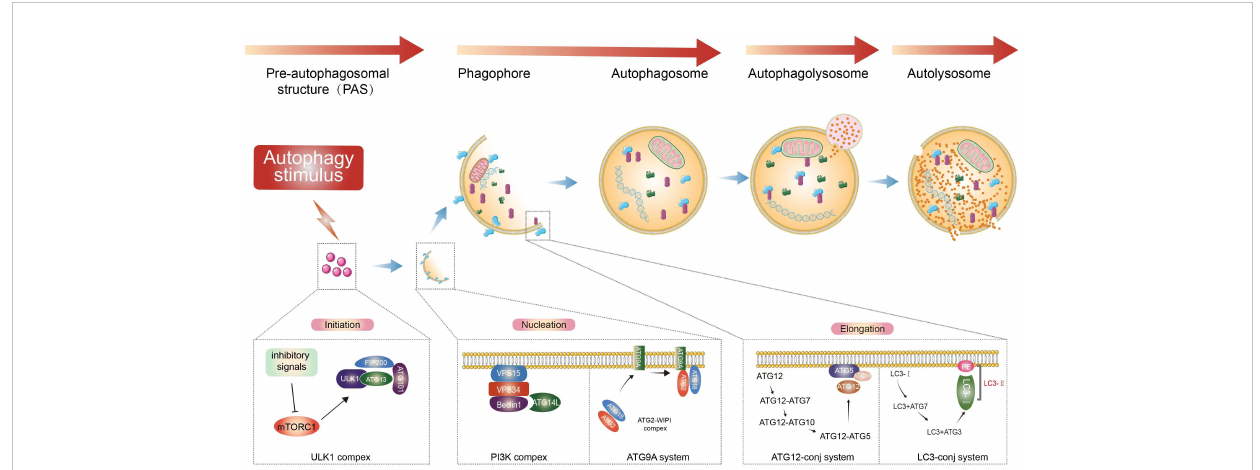
FIGURE 1 Autophagy process. Extracellular stimuli or recognition of substances that induce the formation of autophagosomes. Macroautophagy starts with inhibitory signals acting on mTOR (20). The ULK1 complex is an important upstream initiator that induces the activation of nucleation complexes such as PtdIns3K and BECN1, which in turn binds to autophagosomes and induces the prolongation of phagocytic membranes (21 – 23). Binding of LC3 to autophagosomes and control of autophagosome maturation and extension (24, 25). After vesicle formation, autophagosomes fuse with lysosomes to form autophagic lysosomes, releasing the contents (26 – 28). This is followed by the subsequent degradation of the contents